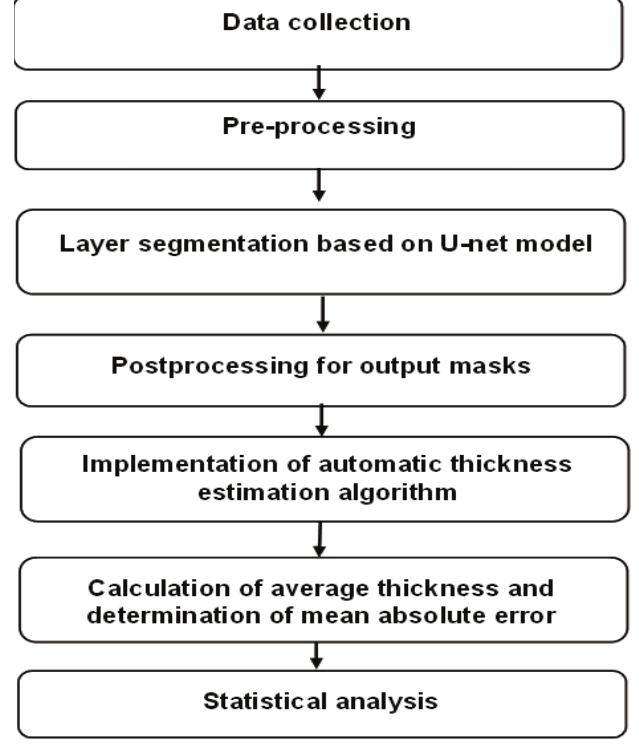
Figure 1. Flowchart for steps in material and